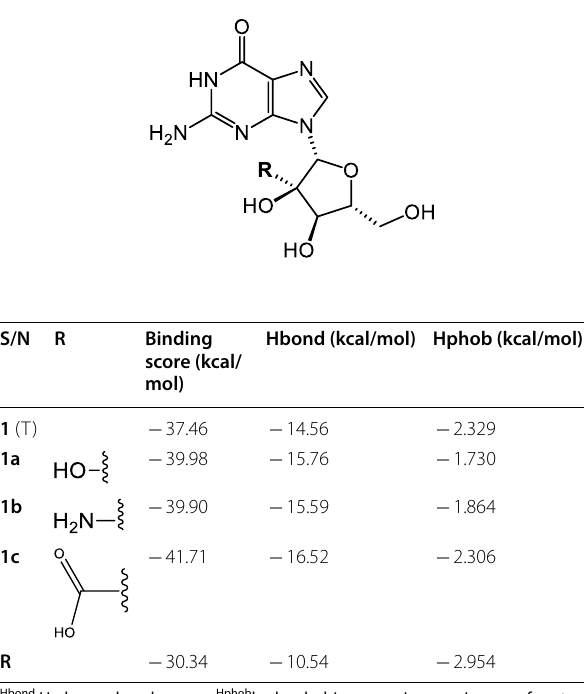
Table 1 The structures and docking outcomes of the